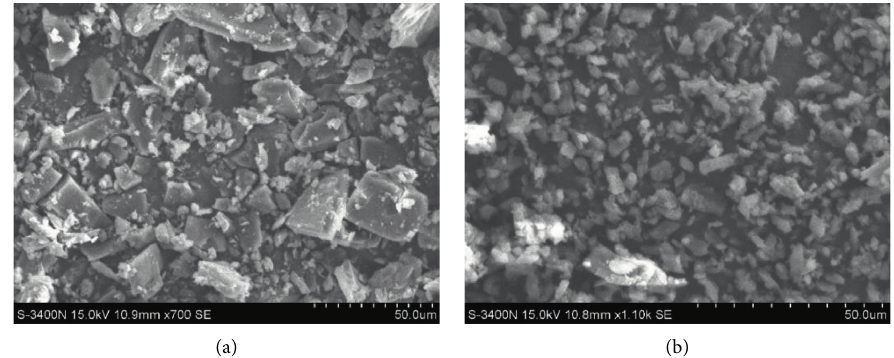
Figure 1: Scanning electron microscope micrographs obtained. (a) Beta-cyclodextrin ( β -CD). (b) Microcapsules with essential oil (EO).